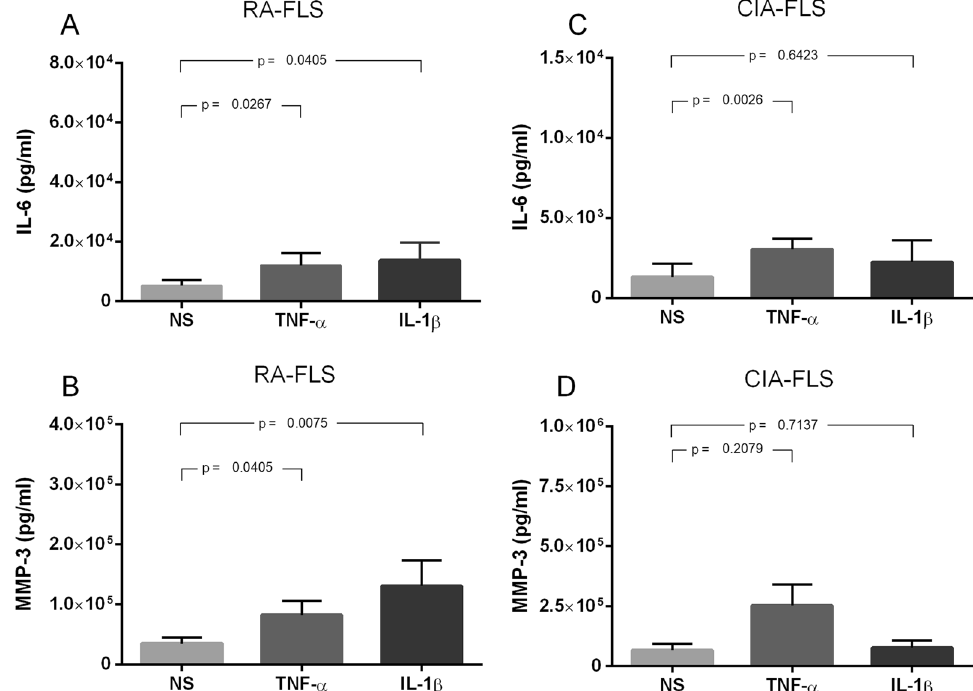
Fig. 6 Production of MMP-3 and IL-6 in response to TNF-α and IL-1β stimulation. Fibroblast-like synoviocytes obtained from patients with rheumatoid arthritis ( A ) and ( B ) (n considered statistically significant. NS MMP-3 metalloproteinase =